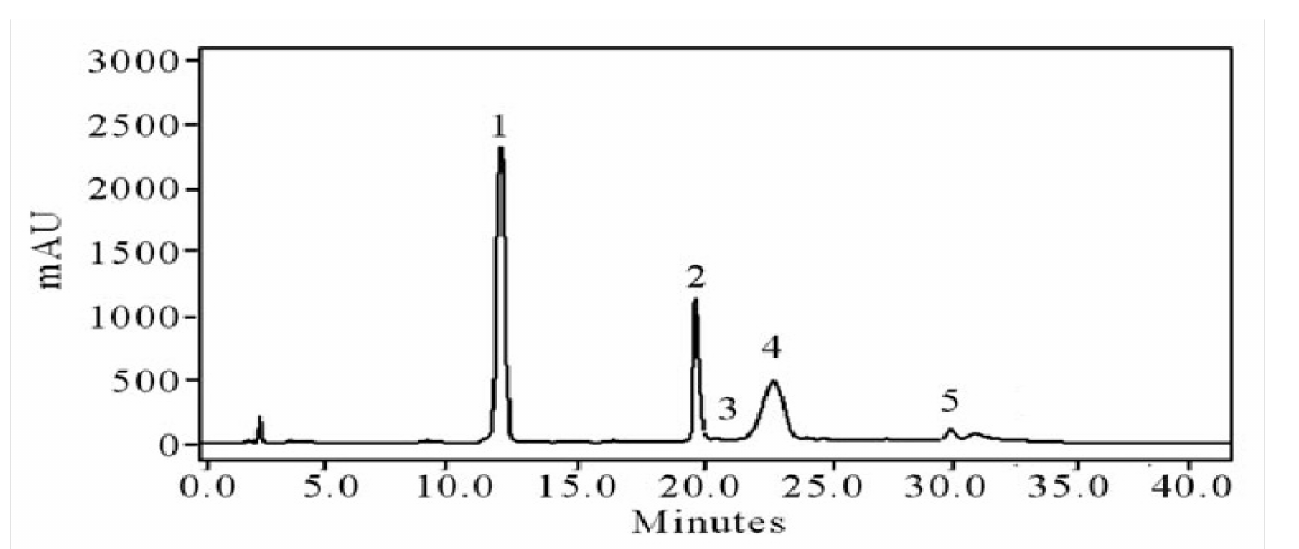
Figure 7. HPLC-DAD chromatogram of major taste of quality compounds of apple with numerical peak (1–5) phloridzin, chlorogenic acid, flavonoids, feurlic acid, P-coumaroylquinic.